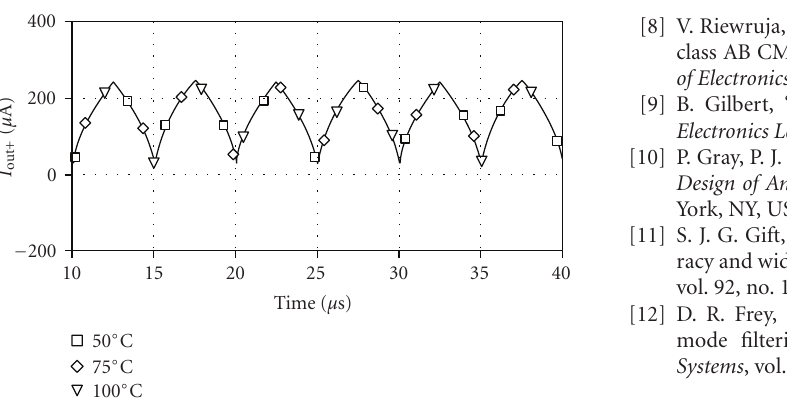
Figure 9: Output waveforms at di ff erent temperatures at 100 kHz frequency input